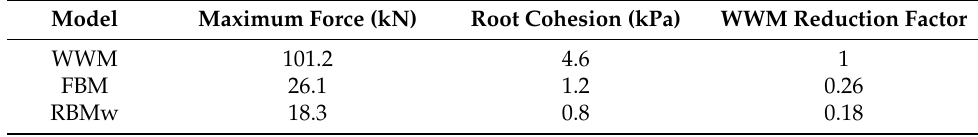
Table 1. Results for root cohesion averaged over the entire CB1 landslide